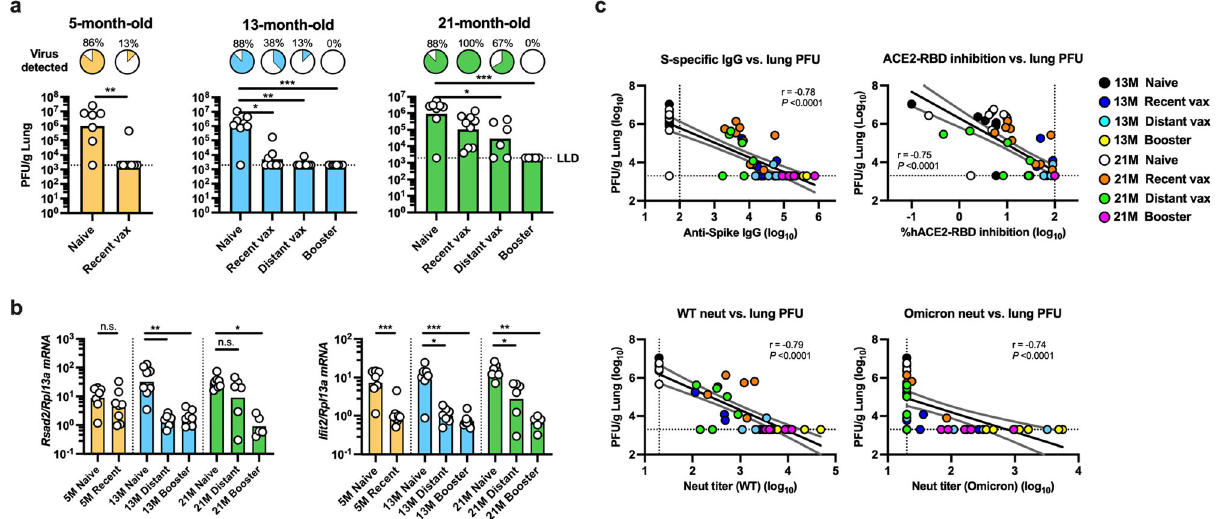
Fig. 4 mRNA booster vaccination protects against lower respiratory infection by SARS-CoV-2 Omicron in aged mice. SARS-CoV-2 mRNA BNT162b2- immunized 5-, 13-, and 21-month-old mice were challenged intranasally with 10 5 plaque-forming units (PFU) of SARS-CoV-2 Omicron at week 38 as indicated in Fig. 1. Viral titers ( a ) and gene expression pro fi les of Rsad2 and I fi t2 shown as relative expression compared to Rlp13a ( b ) in lung homogenates at 2 days post challenge are shown. Bars represent geometric means. Pie charts show the proportion of mice within each group that had detectable virus in the lungs. Data were analyzed by Mann-Whitney test or Kruskal – Wallis test corrected for multiple comparisons. * P < 0.05, ** P < 0.01, *** P < 0.001. N = 7 – 9 per group, except for 21 M Distant vax ( N = 6) and 21 M Booster ( N = 5) groups. c Correlations between lung PFU at 2 days post challenge and anti-spike IgG titer, hACE2-RBD inhibition rate, and pseudovirus neutralizing titers against SARS-CoV-2 WT and Omicron at week 36 are shown. Circles represent individual mice, and colors indicate the immunization regimens. Dotted lines indicate assay limits of detection. Black and gray lines respectively indicate linear regression and 95% con fi dence interval. Correlations were assessed by two-sided Spearman rank-correlation